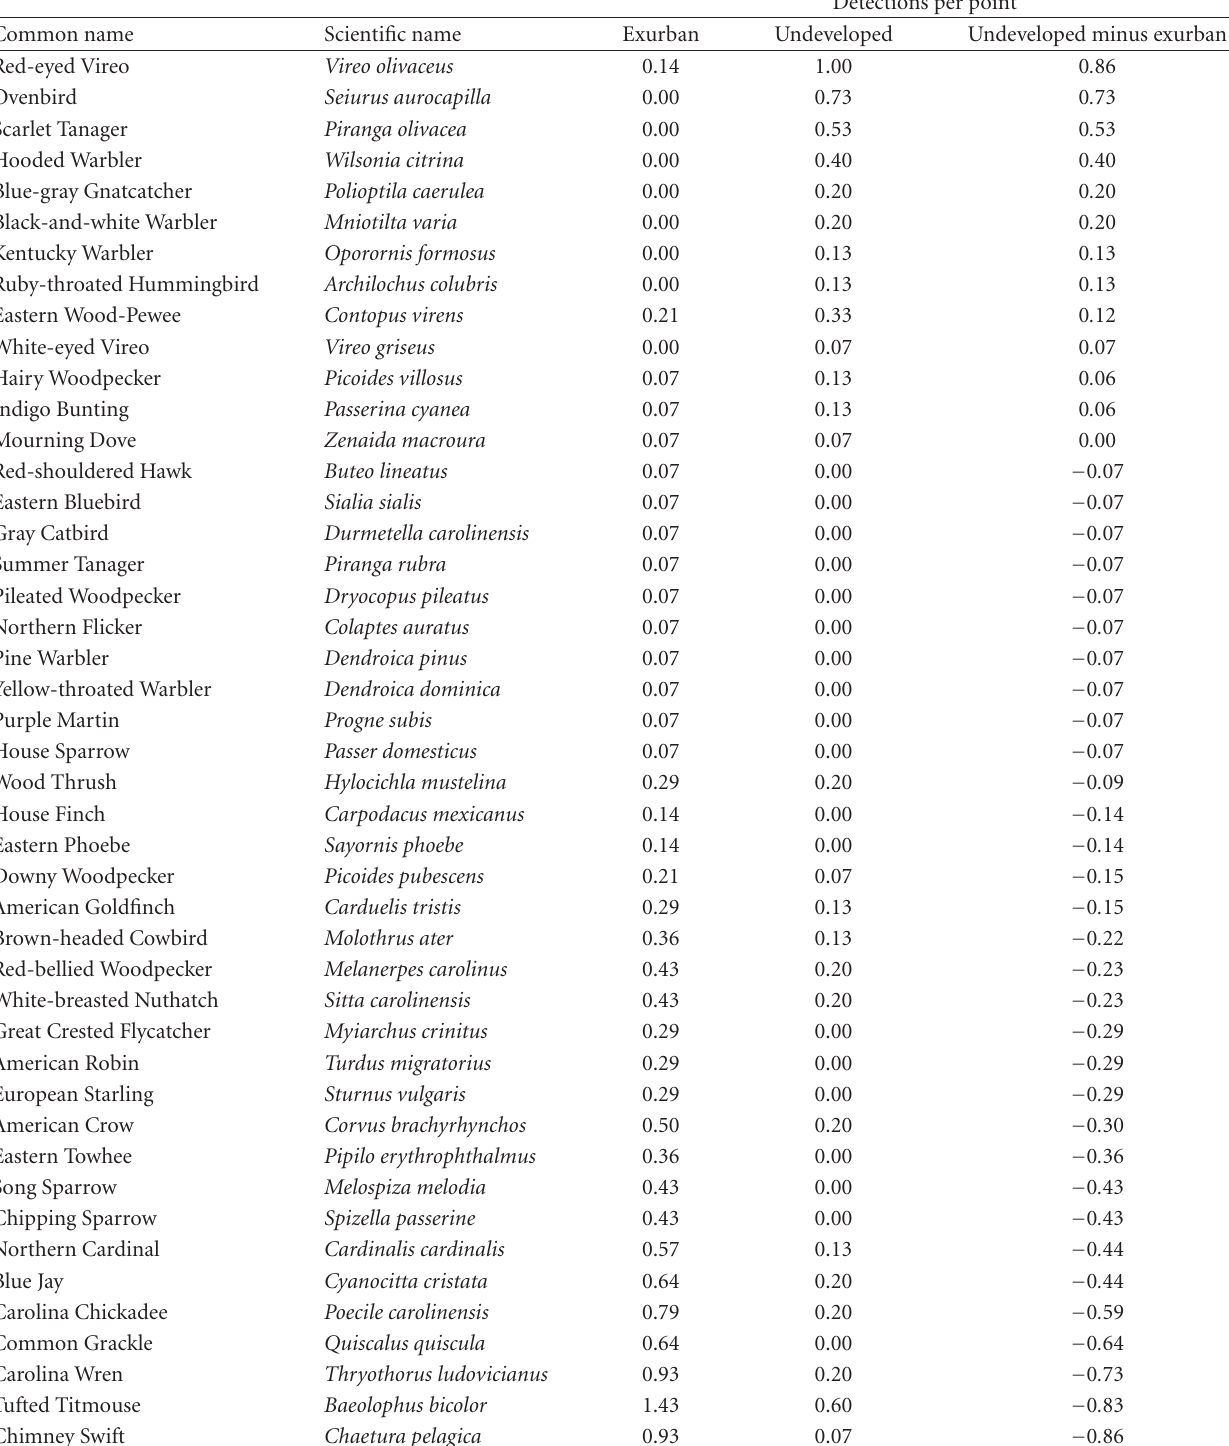
Table 1: Bird species detected during point counts. Species are ranked according to the number of detections per sample point in undeveloped areas ( n = 15) minus the number of detections per sample point in exurban areas ( n = 14 points). Species with positive values of this di ff erence were found mostly undeveloped forests and not in exurban areas, species with values near zero were found in both undeveloped forest and in exurban areas, and species with negative values were found mostly in exurban areas and not in undeveloped